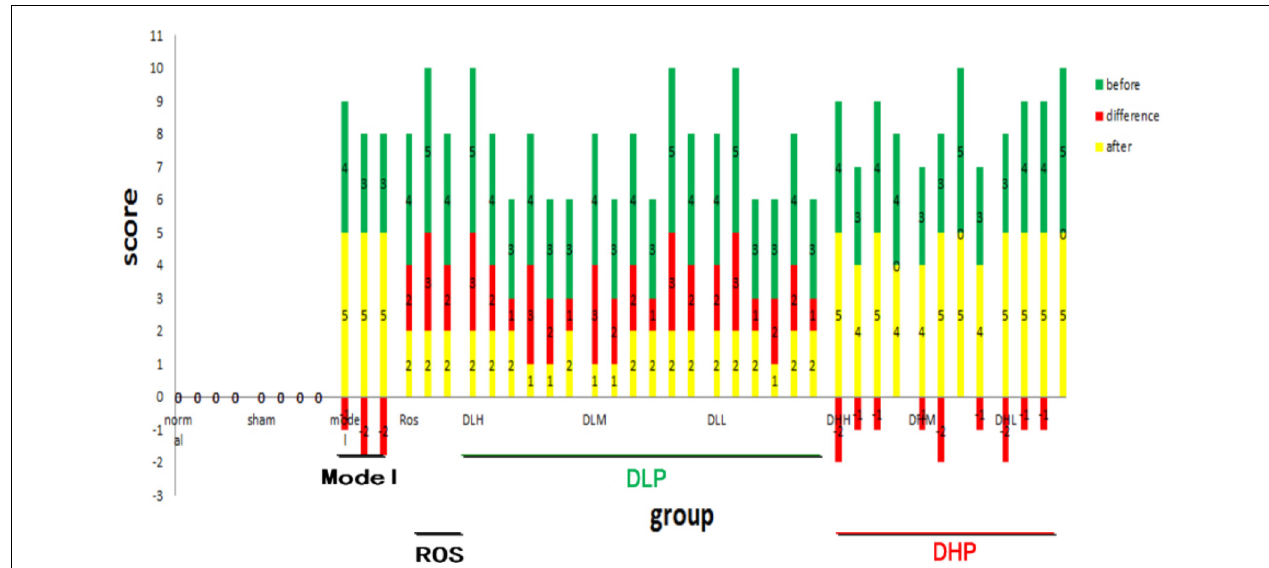
FIGURE 2 | Quantification of the degrees of pulmonary fibrosis by µ CT imaging before and after DLP, DHP, or ROS treatments. X axis represents individual animals in different treatment groups. Scores on Y axis represent severity level of BLM-induced fibrosis. Green and yellow bars indicate before and after drug treatment, respectively, and red bar indicates the differences in between. Negative value means no therapeutic effects.